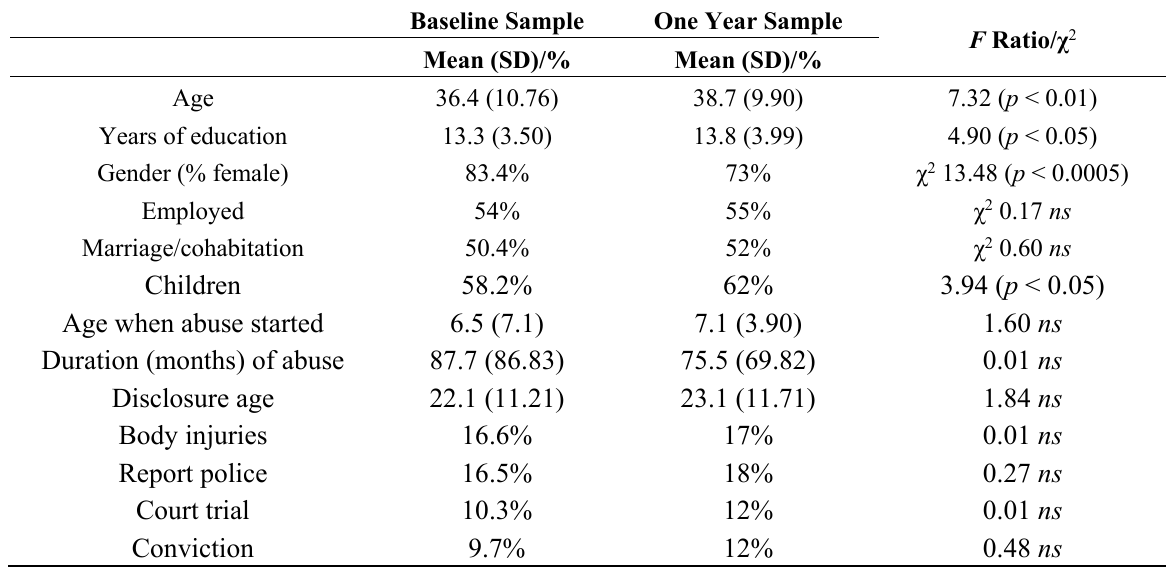
Table 3. Descriptive statistics and test statistics for differences between T1 and T3